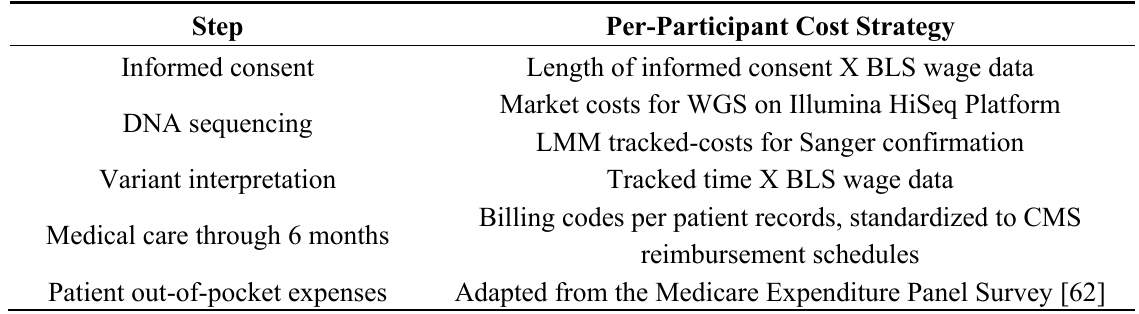
Table 1. Strategy for tracking participant-level costs in the MedSeq